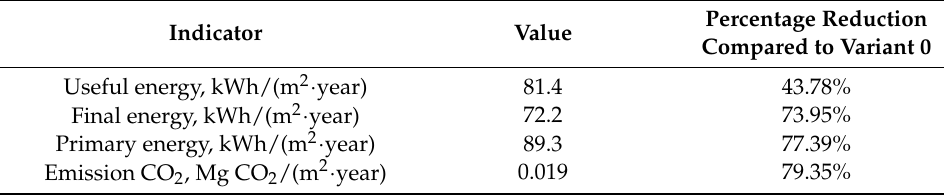
Table 12. Energy performance indicators—variant 3.